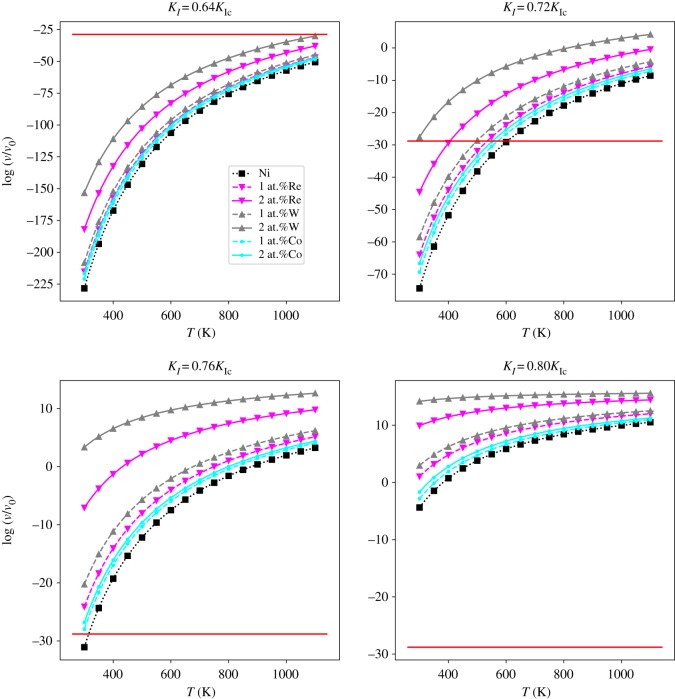
Curves of log (ν/ν0) versus temperature (T) at loads KI = 0.64KIc, KI = 0.72KIc, KI = 0.76KIc and KI = 0.80KIc. The red horizontal lines represent log (νspon/ν0), where νspon denotes the estimated spontaneous nucleation threshold.